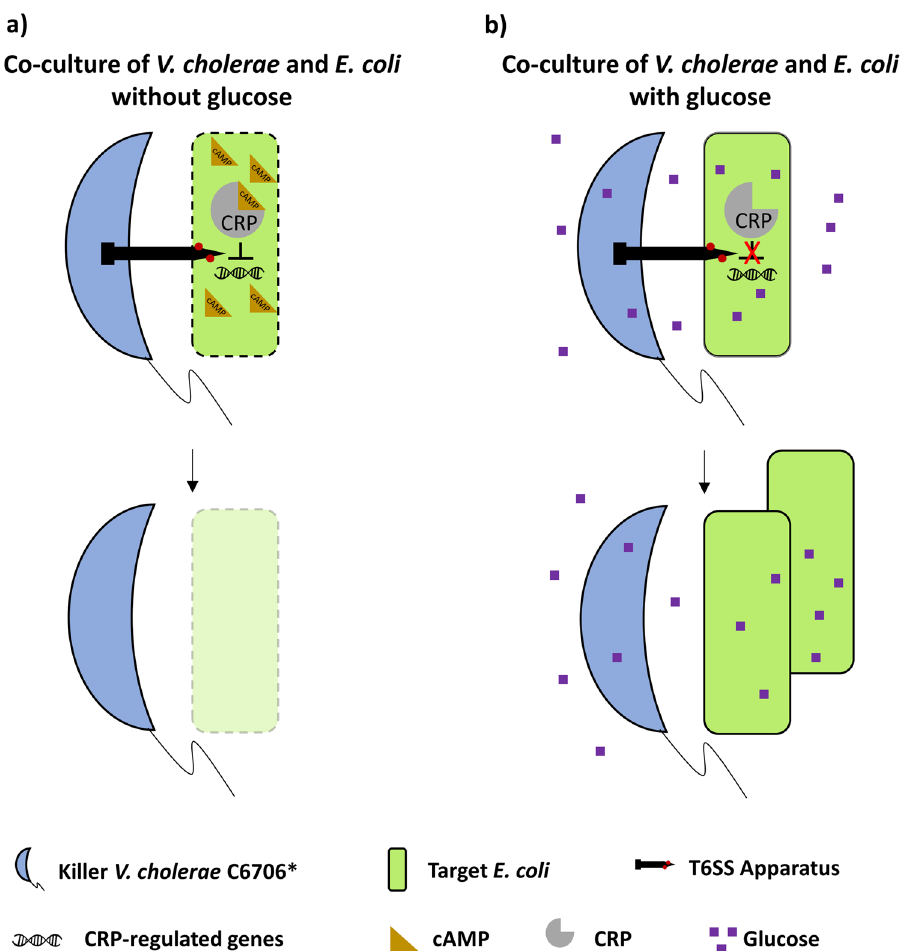
Figure 5. Model depicting the proposed E. coli glucose-mediated protection mechanism against the V. cholerae C6706* T6SS. ( a ) When E. coli cells are grown on rich media in the absence of glucose, CRP is bound by cAMP and represses (directly or indirectly) an unknown gene (or genes). Repression of those genes results in higher susceptibility to T6SS attacks. ( b ) When E. coli cells are grown on rich media in the presence of glucose, CRP is not bound by cAMP and cannot repress the genes it controls under low glucose conditions. As a result, E. coli cells have increased protection against T6SS